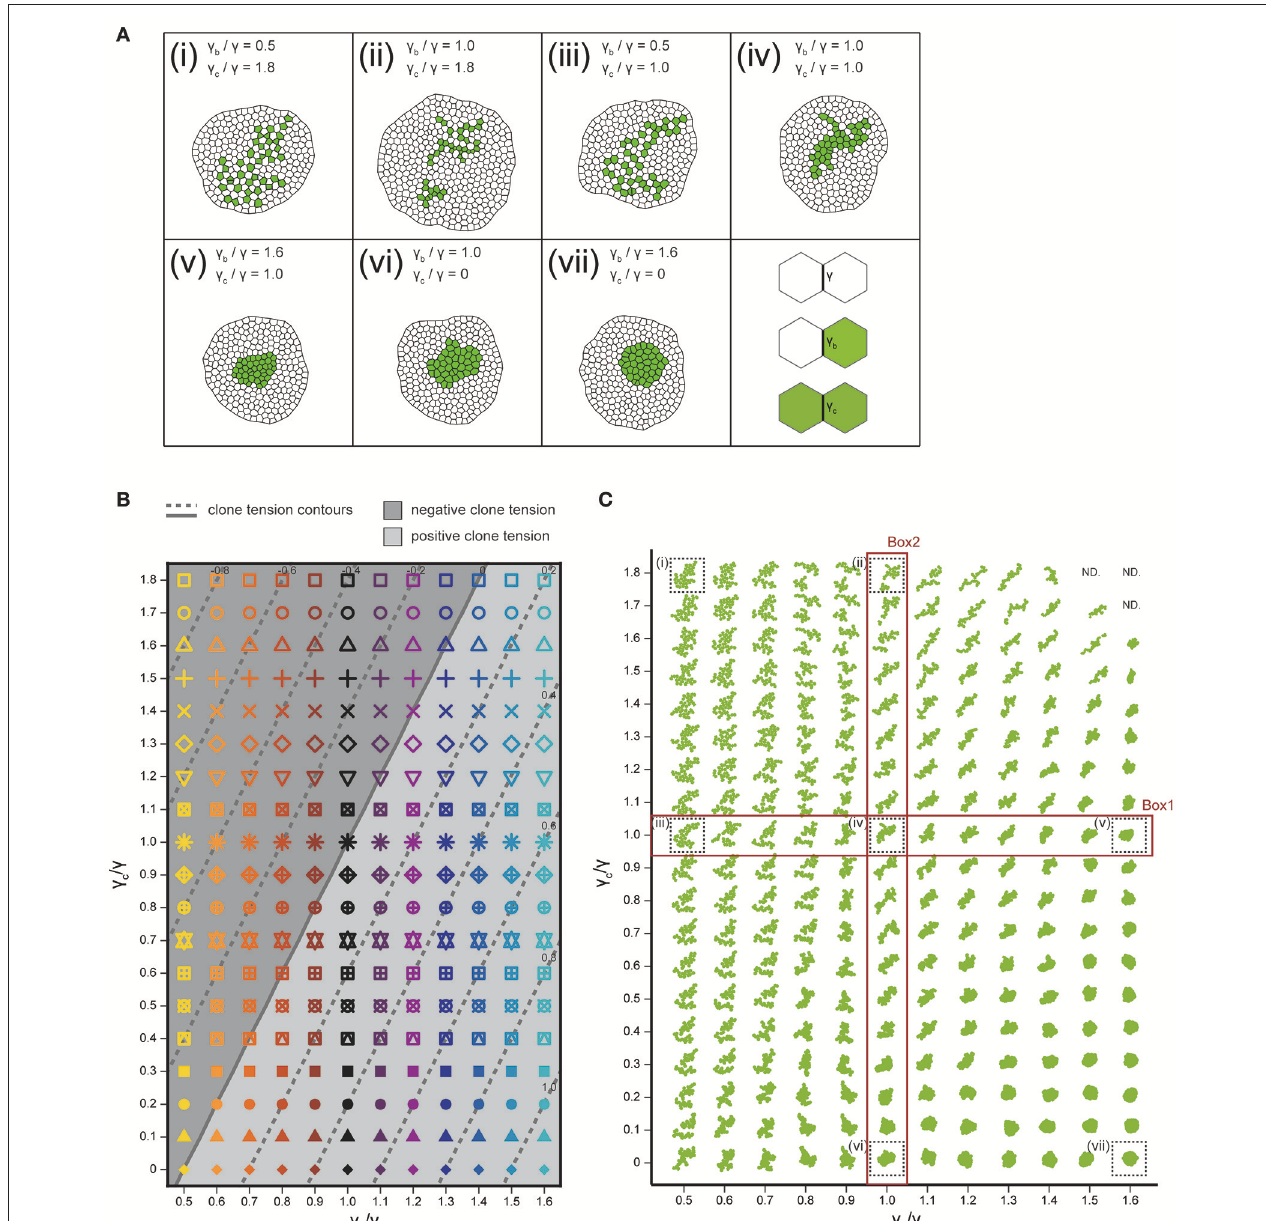
FIGURE 4 | Cell vertex model simulations. (A) Right bottom: The classification of line tension parameters: γ [default tension at edges between non-clonal cells (white)], γ b (clone boundary tension at edges on the clone boundary), and γ c [inner clonal tension at edges between clonal cells (green)]. (i–vii) Snapshots of simulated clones when the total number of green cells is 40. (B) Parameter space of normalized line tension ( γ b / γ and γ c / γ ) with contour lines of clone tension σ (See Section Clone Tension for definition). Each symbol denotes different combinations of parameters ( γ b / γ , γ c / γ ). (C) Representative form of the clones for all simulation parameters in (B) , noting that the model did not work at the three parameter points indicated by “ND.” Clones enclosed within black dashed boxes are the same as those in (i–vii) .